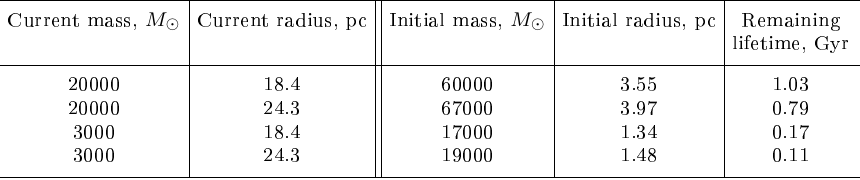
Table 1. Calculated remaining lifetimes, initial mass and radius for Palomar